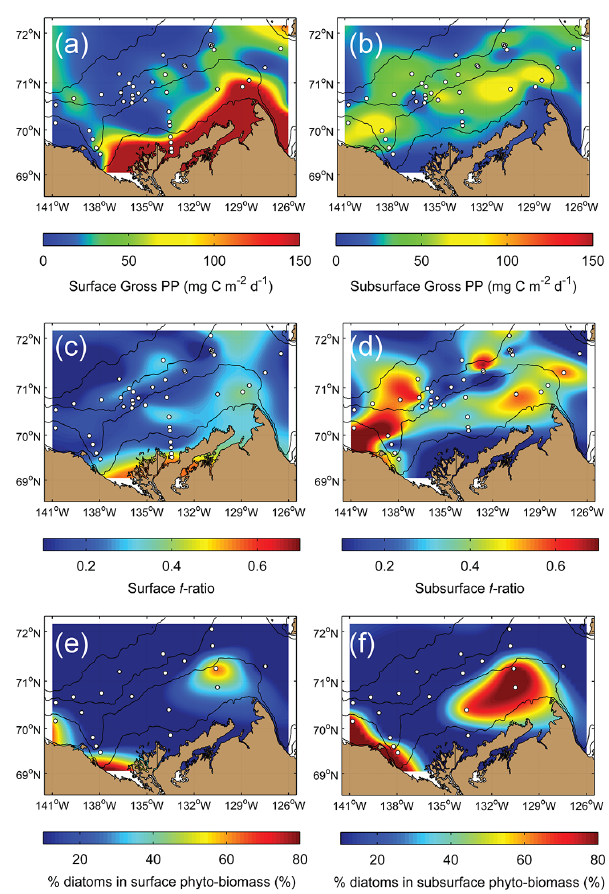
Figure 7. Gridded composites of variables related to phytoplankton dynamics as measured in the surface and subsurface layer of the study region: (a, b) total gross primary production (PP) from field measurements, (c, d) the f ratio of new PP to total PP as estimated on the basis of nitrate and ammonium uptake incubations, and (e, f) the percentage of diatoms in the total phytoplankton biomass. The white dots correspond to the sampling sites. Bathymetric contours are 20, 100, 1000, and